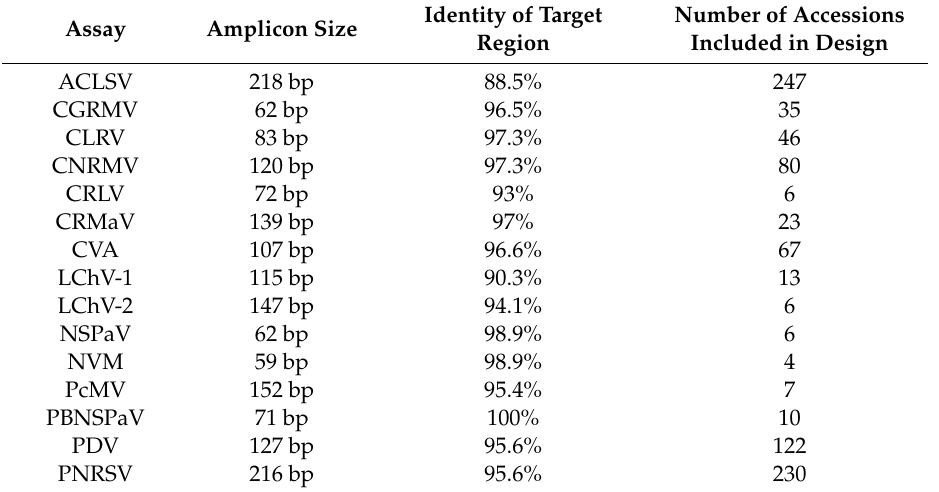
Table 4. Comparison between genome regions amplified by each real-time RT-PCR assay and GenBank accessions included in assay design. Identity of Assay Amplicon Size